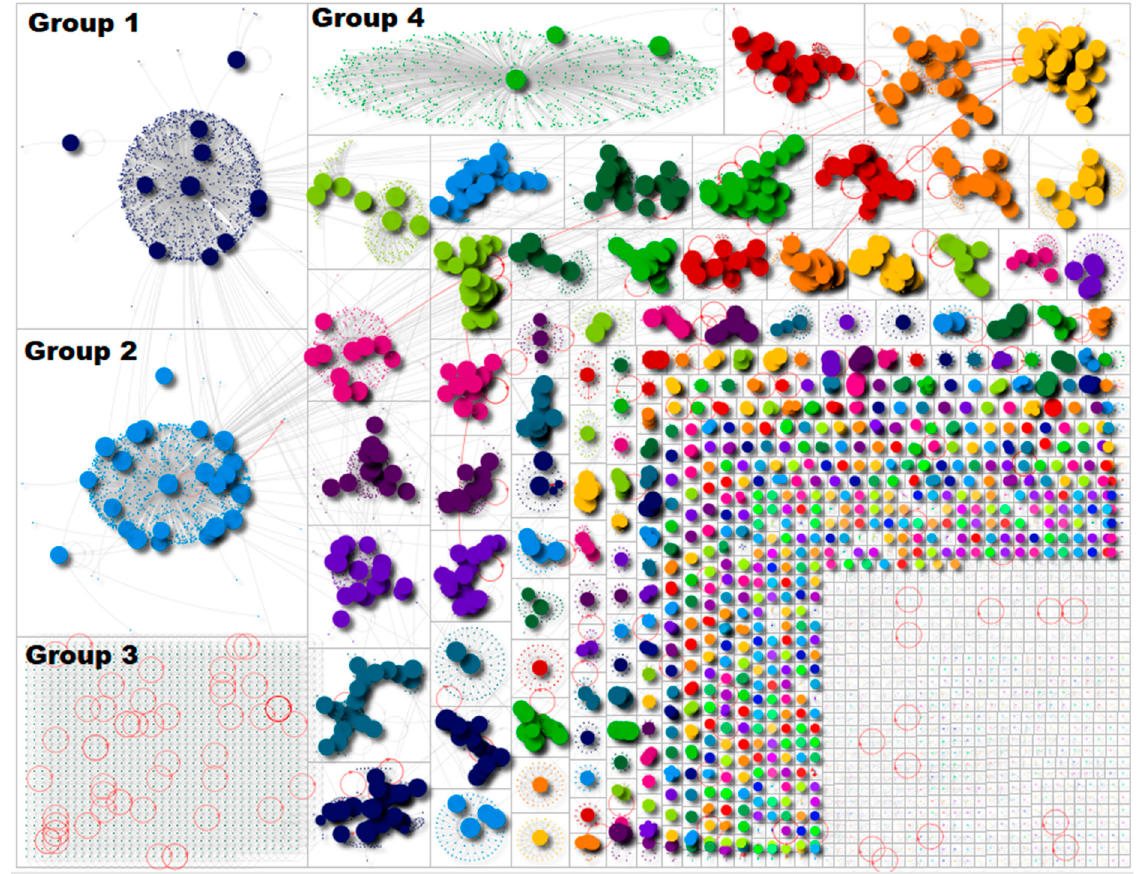
Figure 1. Social network analysis of the keyword ‘blood clots’ from 14 March to 14 April 2021.